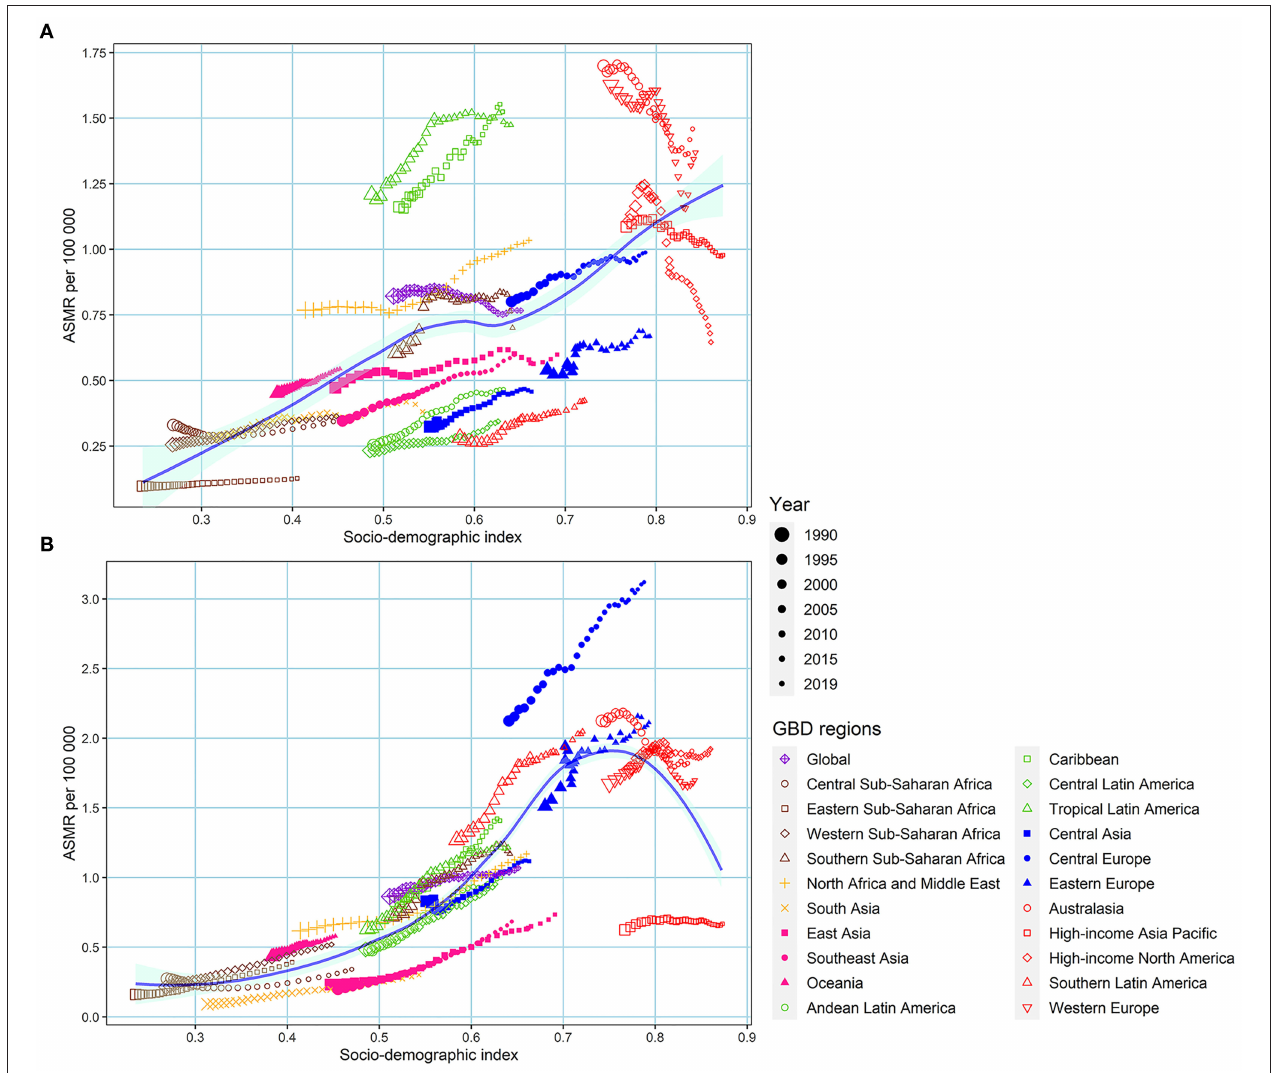
FIGURE 3 | The association between low physical activity and high BMI-induced colorectal cancer ASMR with SDI. (A) low physical activity; (B) high BMI. ASMR, age-standardized mortality rate; SDI, sociodemographic index; BMI, body mass index.